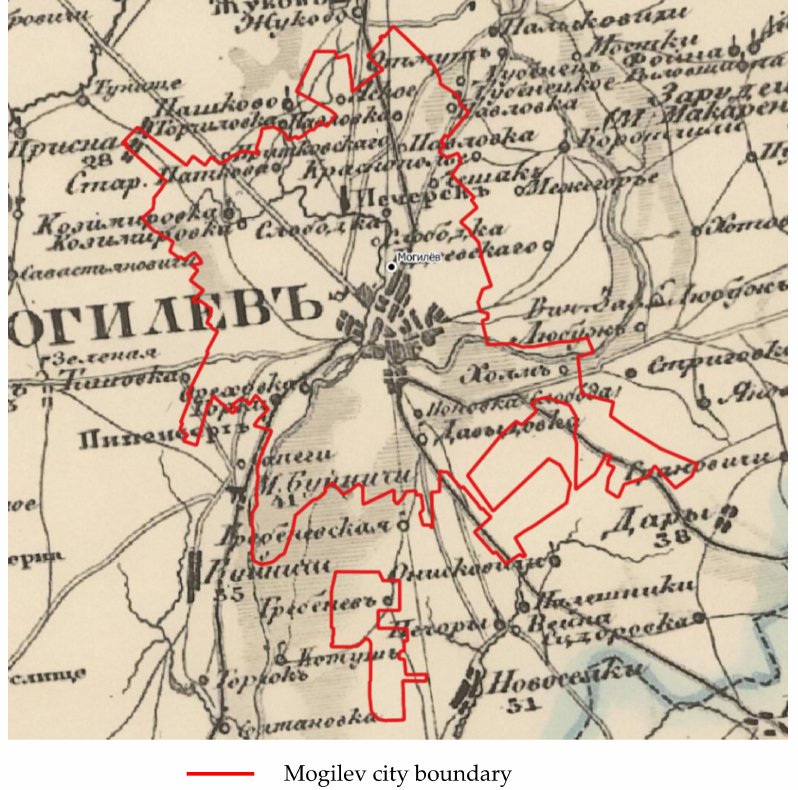
Figure A1. The Mogilev county map tile